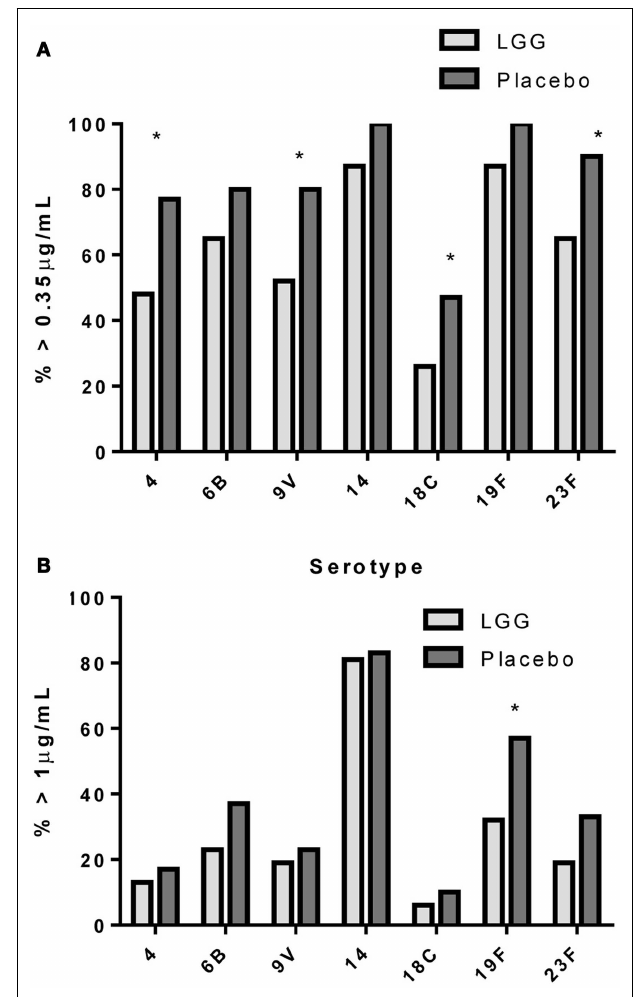
FIGURE 2 | Proportion of infants with a serotype-specific IgG levels ≥ 0.35 µ g/ml (A) or ≥ 1.0 µ g/ml (B) for infants in the LGG ( N = 31) or Placebo ( N = 30) groups following PCV7 immunization . * p < 0.05 comparing LGG and Placebo